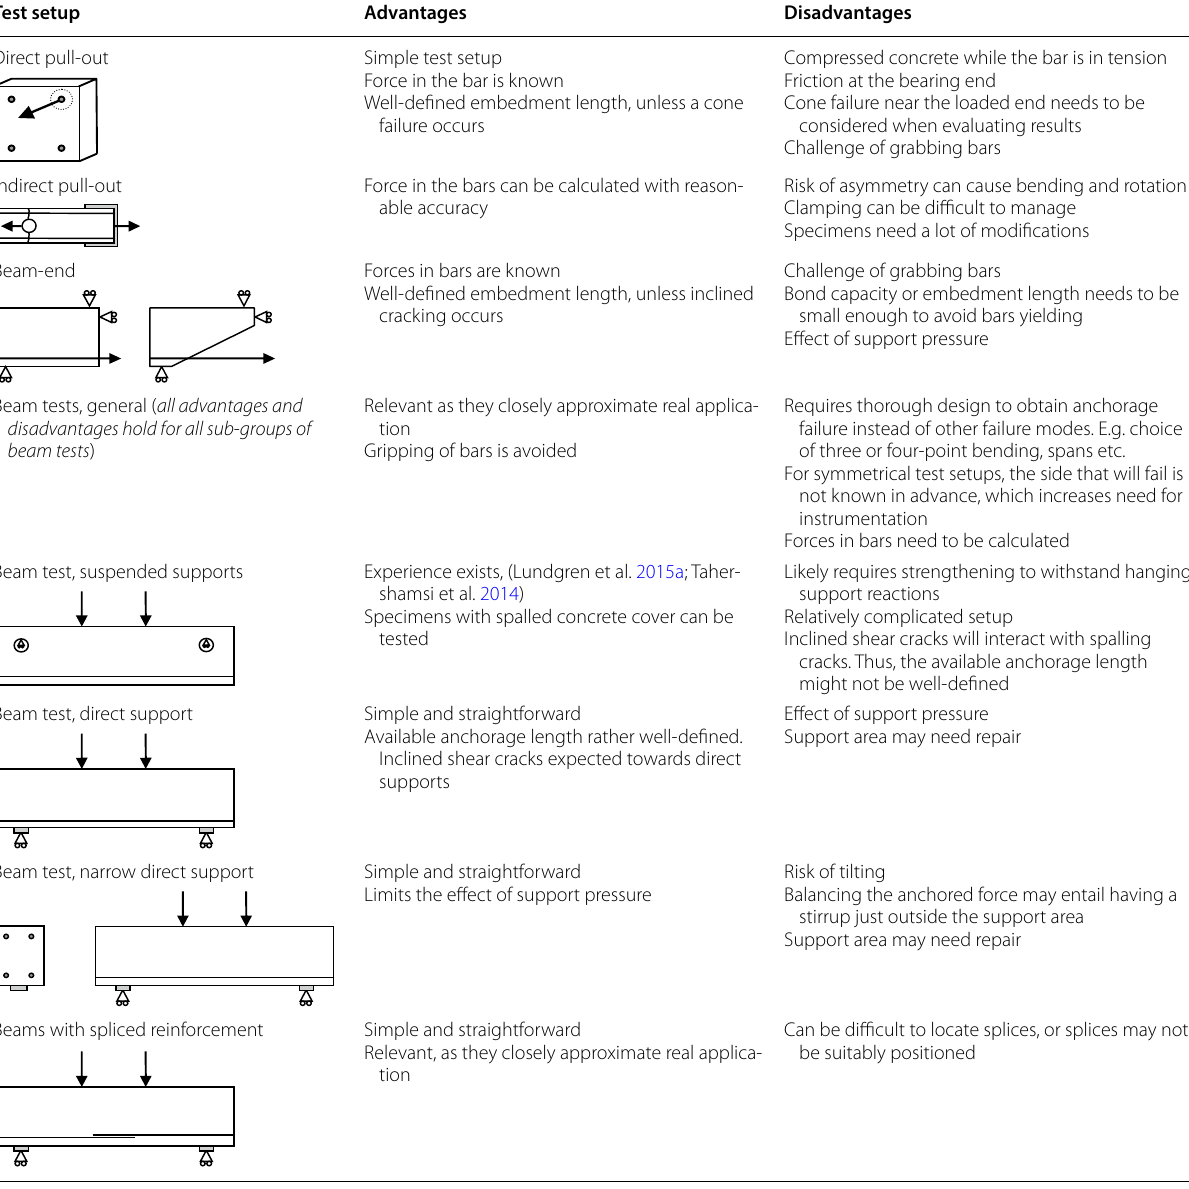
Table 1 Overview of possible test